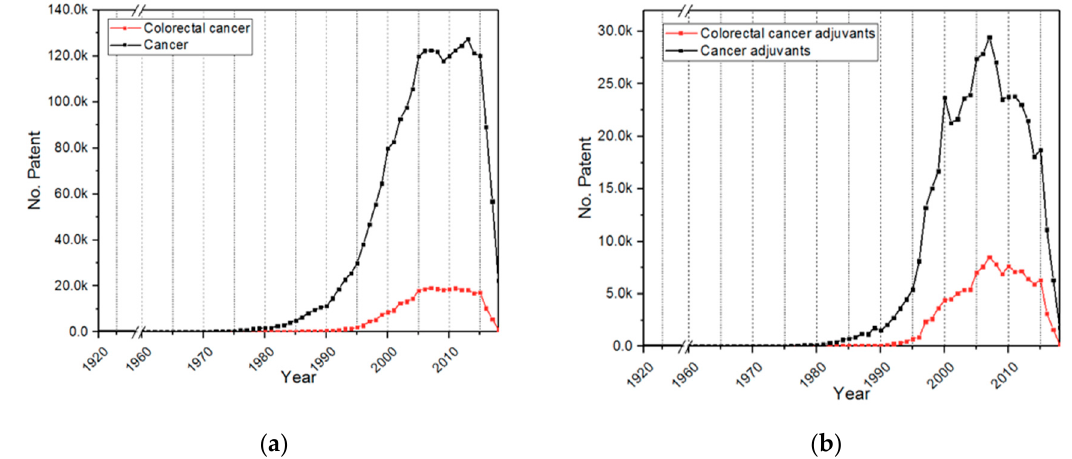
Figure 2. Number of patents per year in ( a ) cancer and colorectal cancer (CRC) (data found in AcclaimIP)—the words “cancer” and “colorectal cancer” were examined in the title, abstract and claims, separately; ( b ) cancer adjuvants and colorectal cancer adjuvants (data found in AcclaimIP)—the words “cancer adjuvant” and “colorectal cancer adjuvant” were searched for in the title, abstract and claims, separately.